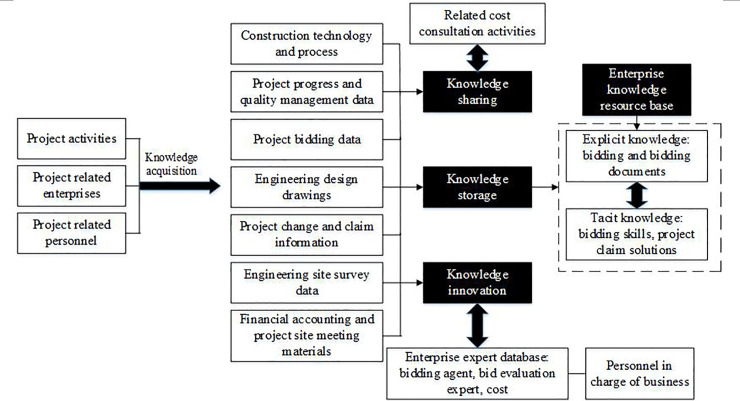
Knowledge management model of engineering cost consulting enterprises.